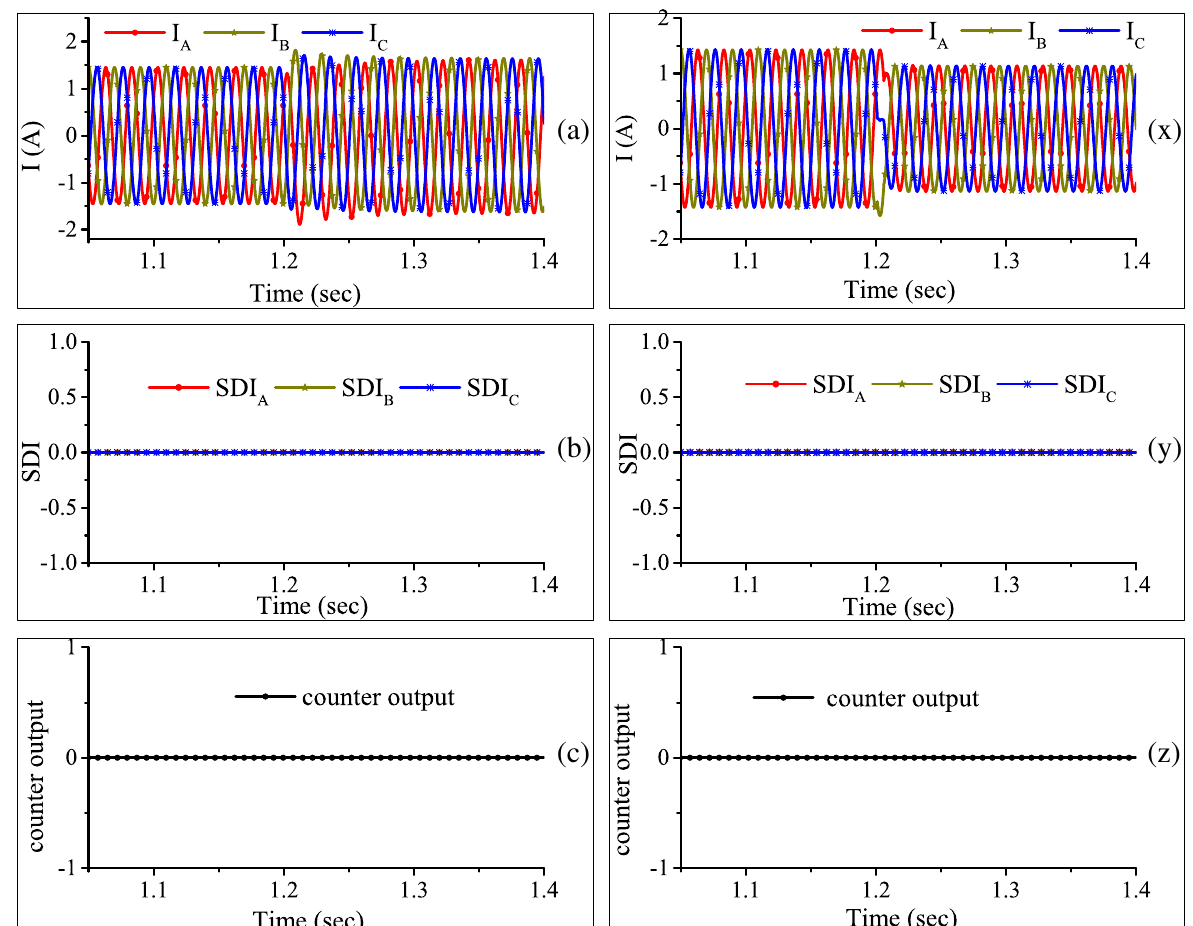
Fig. 6 Sudden load change: ( a ) Current waveforms, ( b ) SDI trajectories ( c ) Counter output during 40% increase in SM3 MVA, ( x ) Current waveforms, ( y ) SDI trajectories ( z ) Counter output during switching OFF of